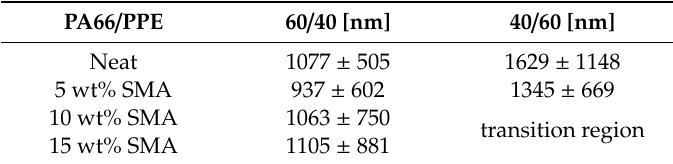
Table 3. Distribution analysis of PPE domain sizes, considering transmission electron microscopy (TEM) micrographs as seen in Figure 4, with a size filter between 200–3000 nm.